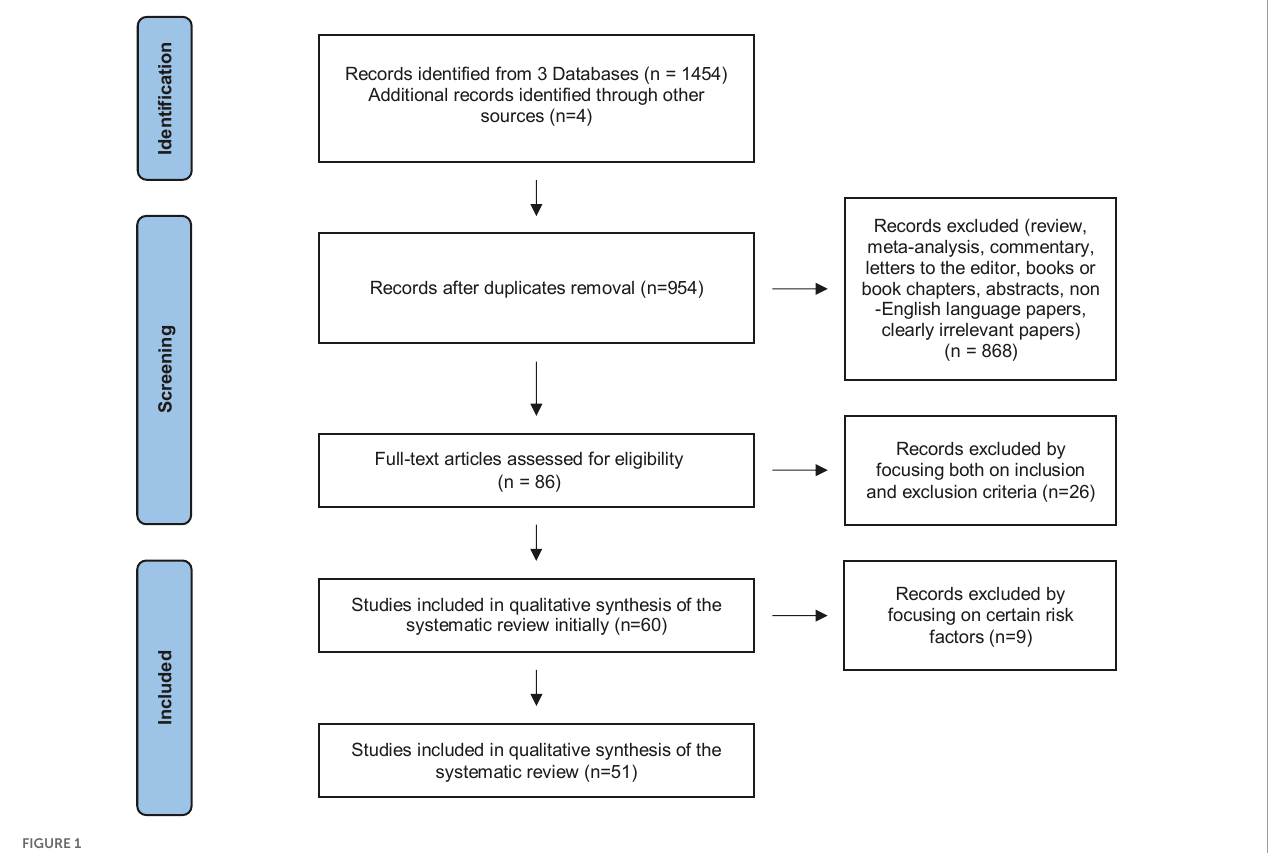
FIGURE1 PRISMA flowchart of the systematic